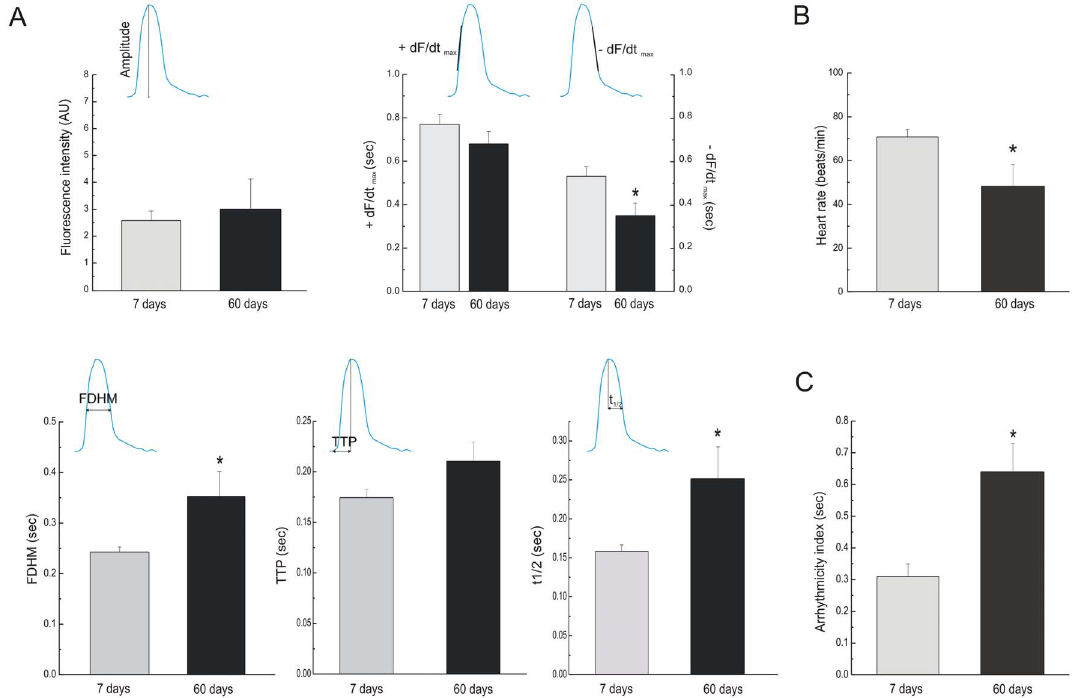
Figure 2. Effects of aging on functional parameters measured through the genetic codified indicator. A. Old flies did not exhibit changes of fluorescence intensity (Top and left graph) neither + dF/dt max compared with younger ones, but reduction of –dF/dt max was observed with aging (Top and right graph). Old flies exhibited prolongation of FDHM (Bottom and left graph) without significantly changes in TTP duration (Bottom and middle graph) but they shown a lengthening of half relaxation time relative to young flies (Bottom and right graph). B. Old flies presented reduction of spontaneous heart rate. C. An increase of arrhythmicity index was observed in 60 days old flies compared with 7 days old individuals. Mean 6 SEM of 57 flies. *p # 0.05.